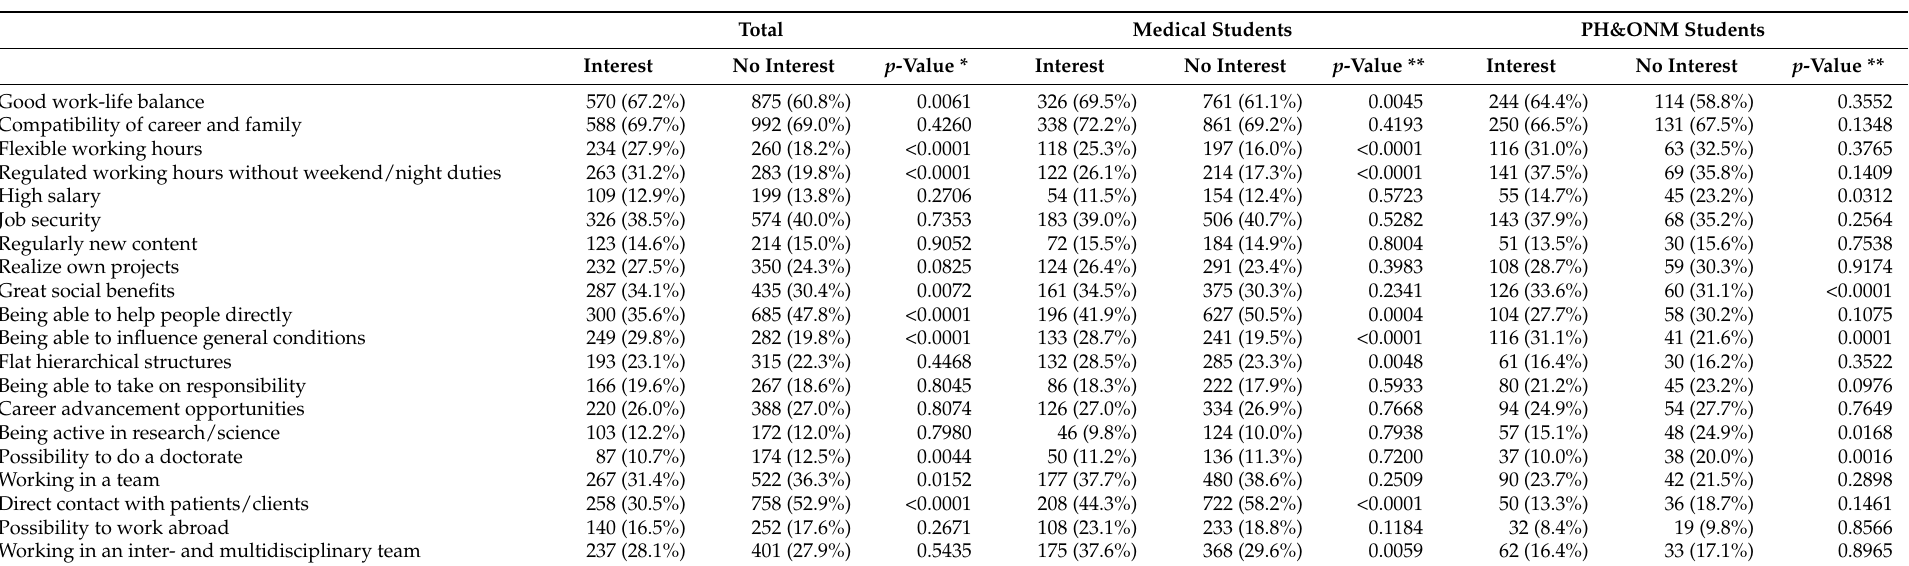
Table 5. Expectations of future working life and career among medical students and PH&ONM students in Germany according to their PHS interest: Absolut and relative proportions of aspects considered as “very important” in wave 1,